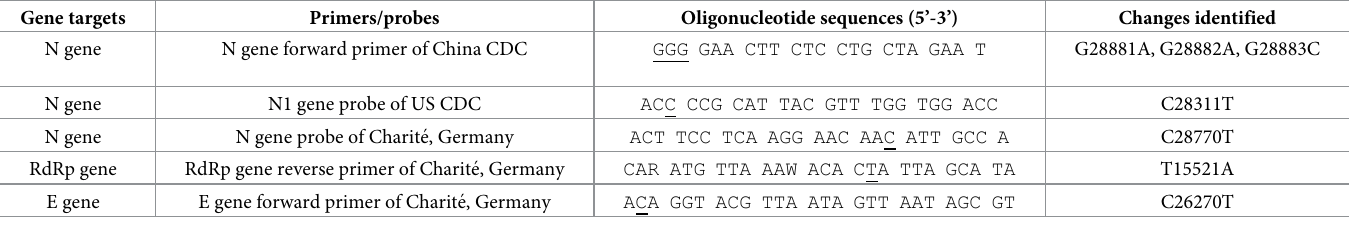
Table 4. The polymerase chain reaction (PCR) primers and probes changes in WHO listed SARS-CoV-2 primers and probes found in Omicron subvariants BA.2.2 and BA.2.10.1. The positions of the nucleotide changes in the primer/probe sequences are highlighted. Gene